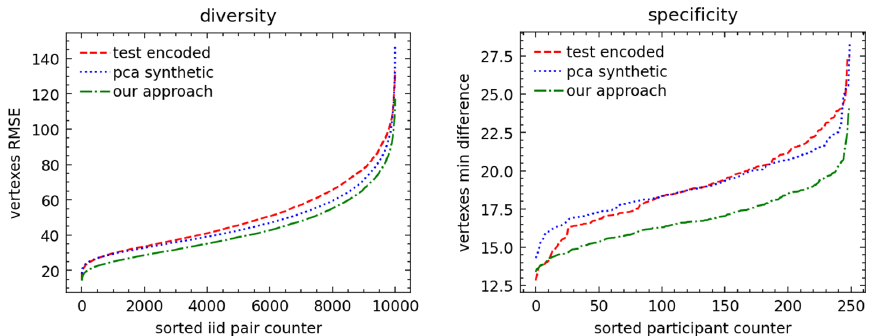
Figure 9. The full ‐ body metrics. The full ‐ body metrics do not show promising results as in the facial geometry, and further experiments are necessary to reach the desired quality of scans. Both diversity and specificity for our approach are lower than test set distributions, thus allowing us, for example, to calibrate the model and increase the variability of the scans by raising the sampling temperature and, therefore, increasing the entropy, diversity, and specificity of the